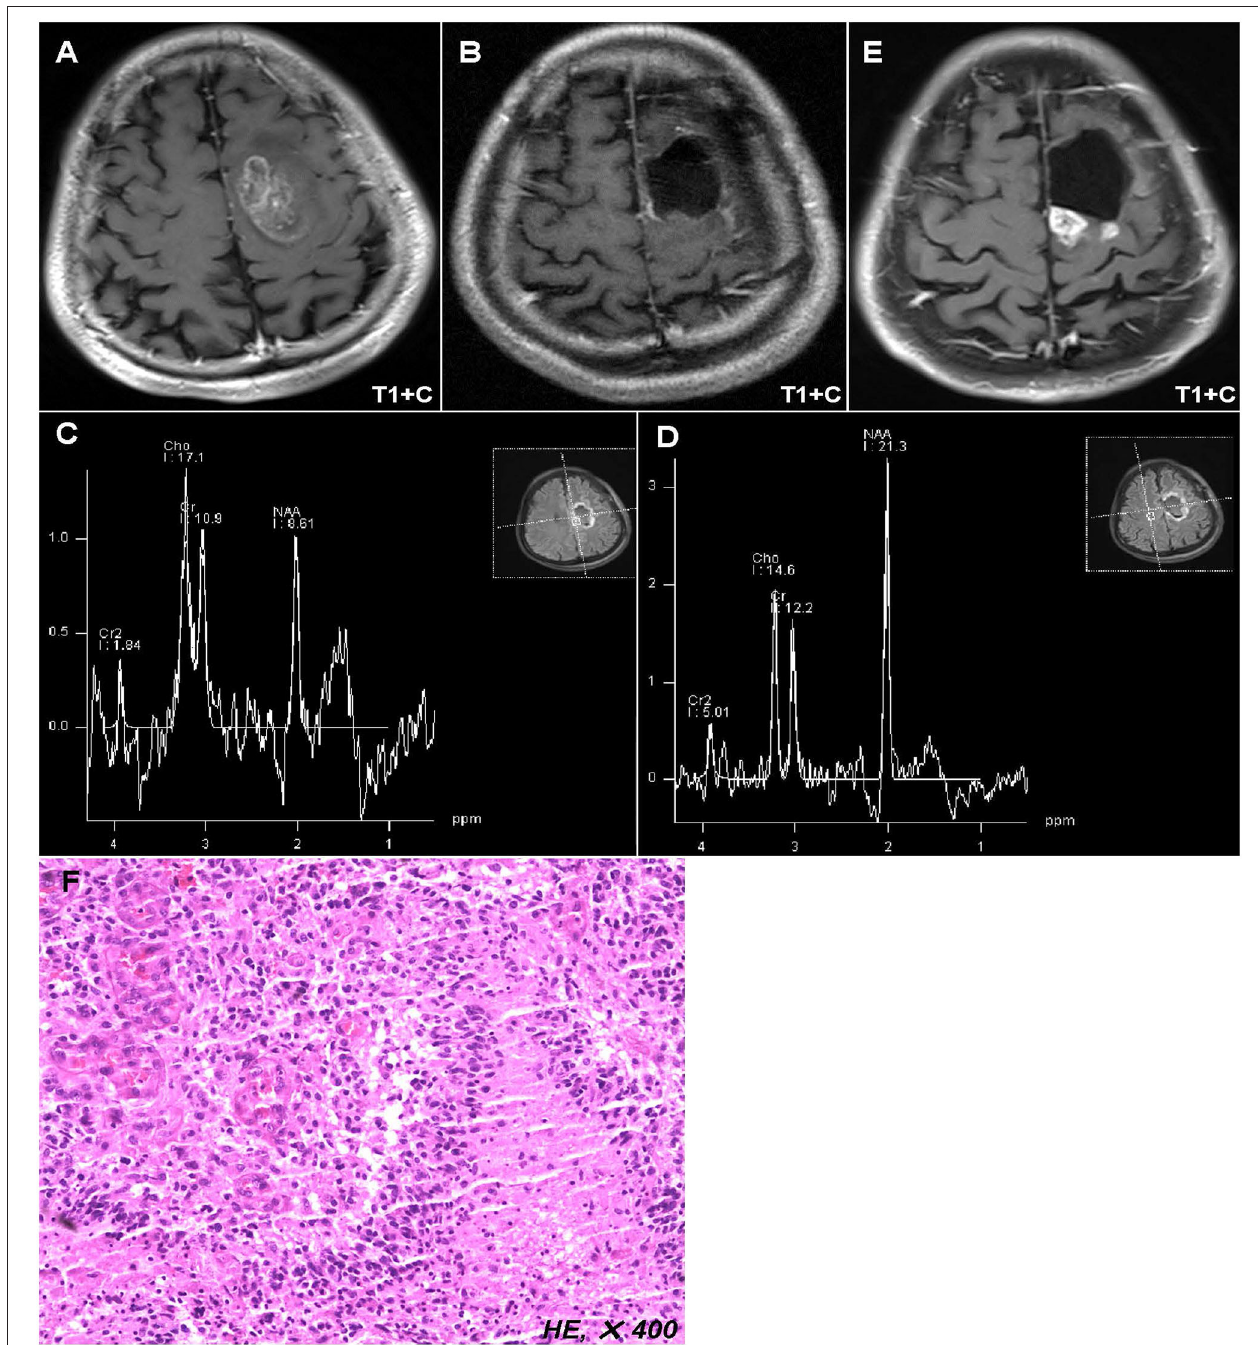
FIGURE 1 | Representative case of this study. Preoperative MR images showed a lesion located in the left anterior central gyrus and supplementary motor area (A) . Postoperative MR images displayed that the tumor has been totally removed (B) , while the postoperative peritumoral zone showed a higher ratio of Cho/NAA ( > 1.31) than that in the contralateral region (C,D) . Twelve months after operation, the MR images showed a new enhanced lesion in the peritumoral zone (E) , which was further confirmed as tumor recurrence by biopsy (F)